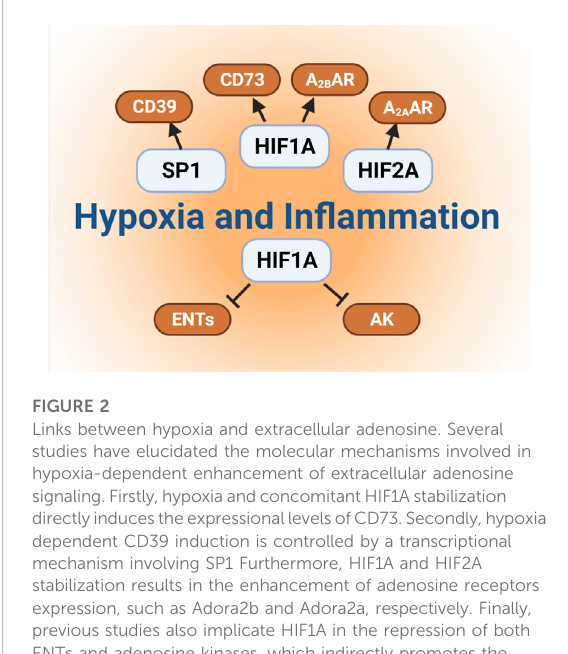
FIGURE 1 Extracellular adenosine generation, signaling, and termination. Extracellular adenosine can be enzymatically produced from precursor nucleotides, which involves a two-step enzymaticprocessinvolvingtheconversion fromATPorADP to AMP. This conversion is controlled by ecto-apyrase CD39. The second step for the extracellular generation of adenosine is mediated by the ecto-5 ′ -nucleotidase CD73, a glycosylphosphatidylinositol (GPI)-anchored protein that converts AMPtoadenosine,andfunctionsasanextracellularpacemakerfor the production of adenosine. Once liberated into the extracellular compartment, adenosine binds to four G-protein coupled adenosine receptors, including the Adora1, Adora2a, Adora2b and the Adora3 adenosine receptor with speci fi c biologic functions during health or disease. Finally, extracellular adenosine signaling is terminated via ENTs to be uptaken into the intracellular space and converted to inosine or AMP.